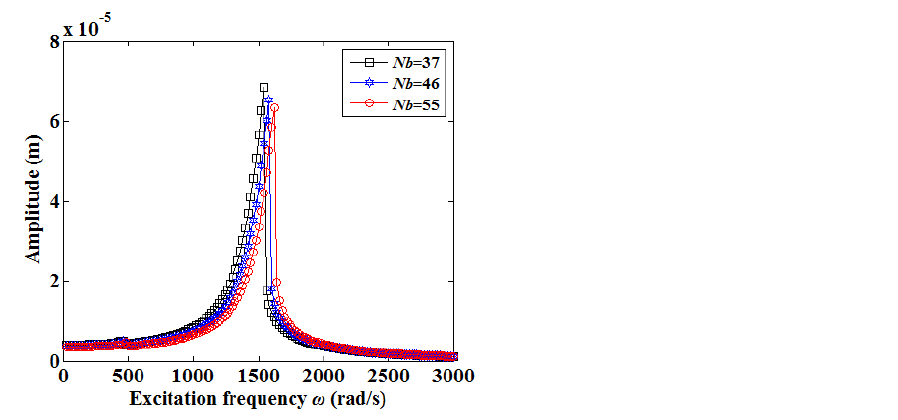
Figure 18. Amplitude-frequency curves of the feed system for different numbers of loaded balls.